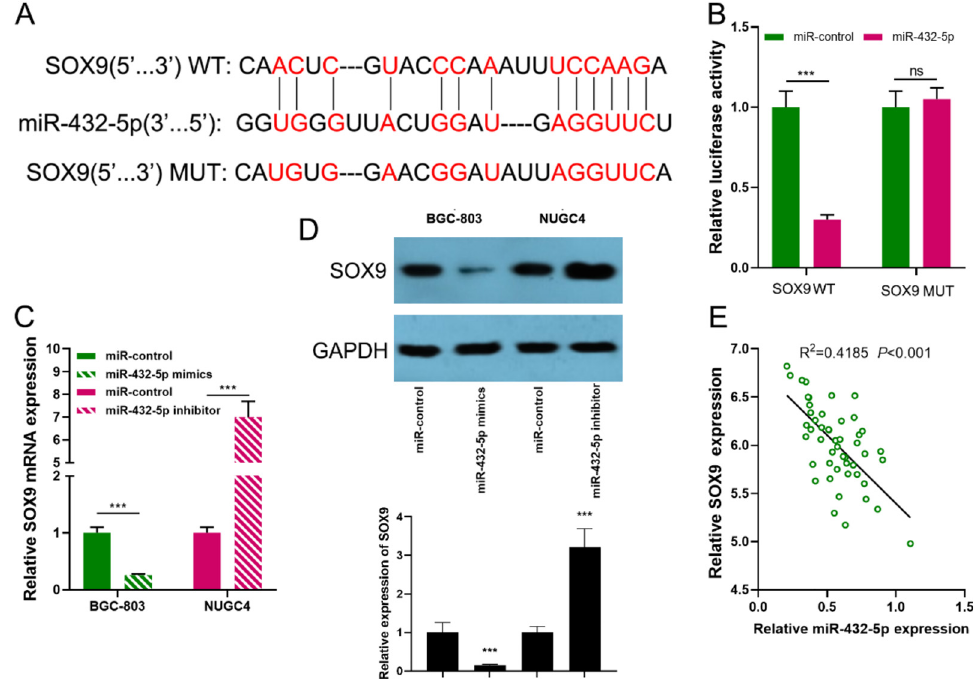
Fig. 4. SOX9 is a direct target of miR-432-5p. (A) StarBase database was used to predict the binding site between miR-432-5p and the '3 ′ UTR of SOX9. (B) A dual-lucif- erase reporter assay was used to con fi rm the interaction between miR-432-5p and the '3 ′ UTR of SOX9. (C-D) qRT-PCR and western blot assays were used to detect the expression of SOX9 after miR-432-5p was overexpressed or inhibited. (E) ' 'Spearman's correlation analysis was used to analyze the correlation between the expression levels of SOX9 and miR-432-5p in GC tissues ( n =50). WT, Wild Type; MUT, Mutant Type; ns, not signi fi cant; *** p < 0.001.